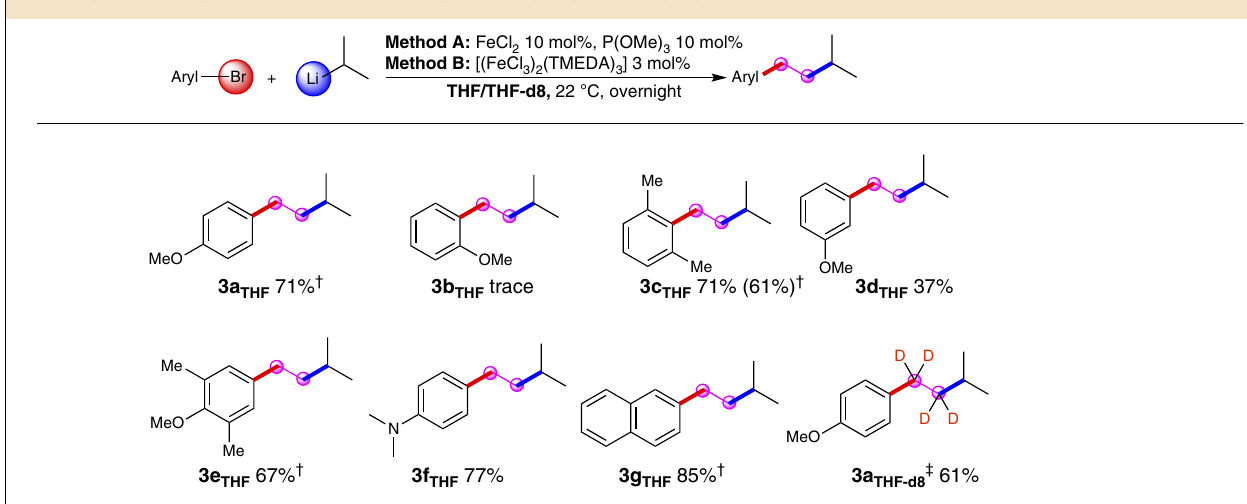
Table 3 | Iron-catalysed release-capture ethylene coupling with isopropyllithium*.